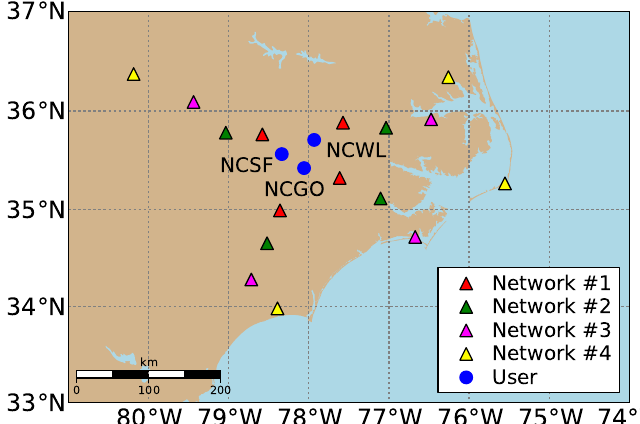
Figure 2. Geographic distribution of the selected CORS receivers in North Carolina used for the PPP-RTK network and user processing. The network receivers are classified in groups of four to form networks of varying inter-station distance and are denoted by red, green, magenta and yellow triangles in ascending order by distance. The remaining three receivers, denoted by blue dots, represent the user